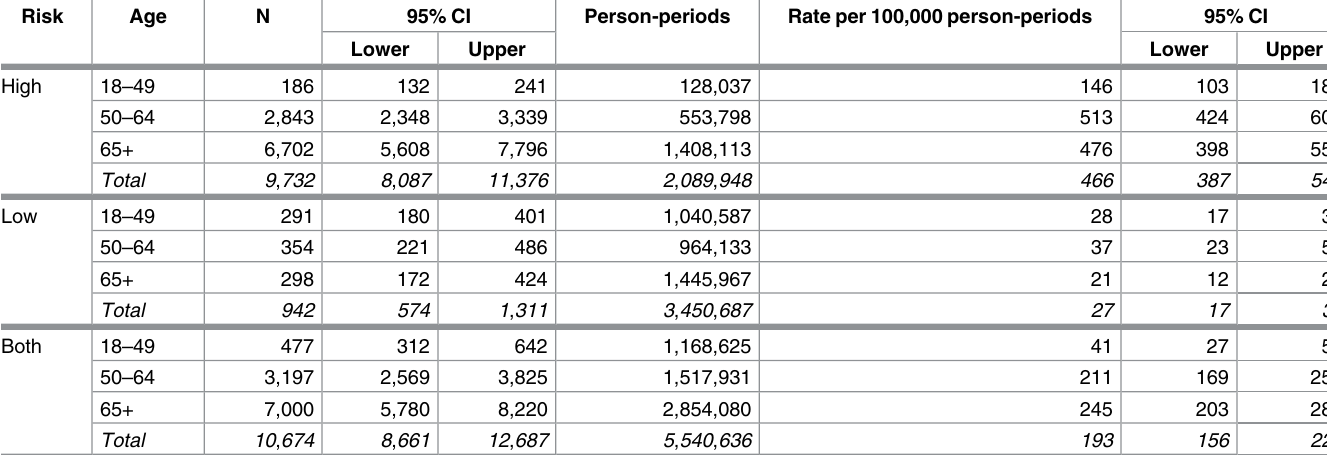
Table 1. Annual estimates of influenza-attributed ED visits 1 by risk and age group averagedover five respiratoryseasons.